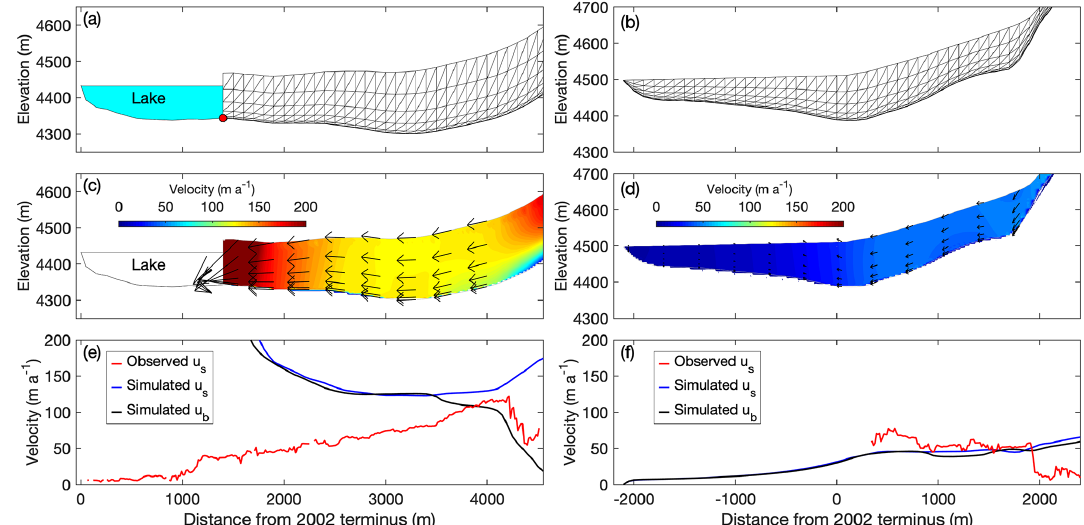
Figure 6. Ice flow simulations in longitudinal cross sections of Thorthormi Glacier under the lake-terminating condition (a, c, e) , and Lugge Glacier under the land-terminating condition (b, d, f) . (a, b) Finite element meshes used for the simulation. The light blue shading in (a) indicates the proglacial lake in front of Thorthormi Glacier. Simulated (c, d) two-dimensional flow vectors (magnitude and direction) and (e, f) horizontal components of the flow velocity. The blue and black curves are the simulated surface ( u s ) and basal velocities ( u b ), respectively. The red curves are the observed surface flow velocities for